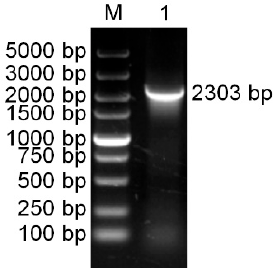
Figure 1. The PCR amplification product of the PaPAL gene. M: DNA molecular weight standards; 1: The PCR product of full-length cDNA.